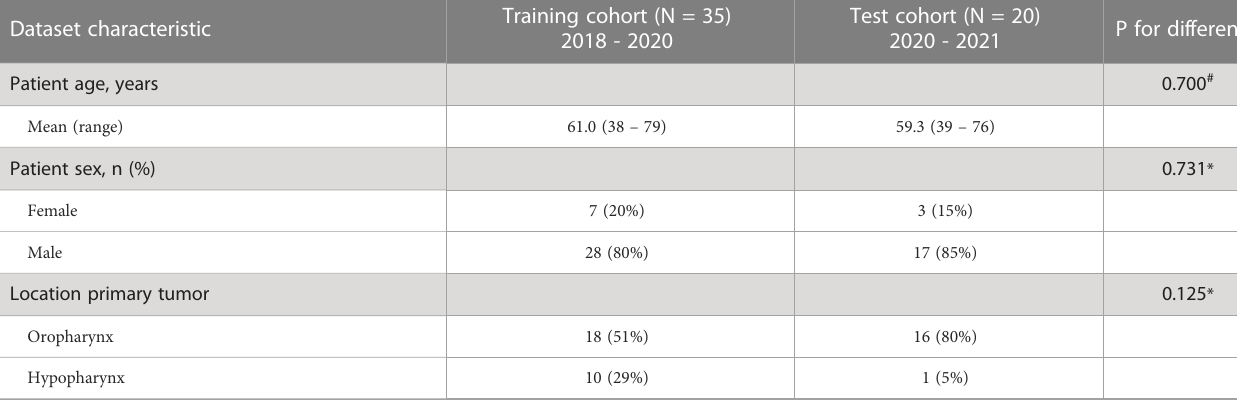
TABLE 1 Characteristics of the training and test data